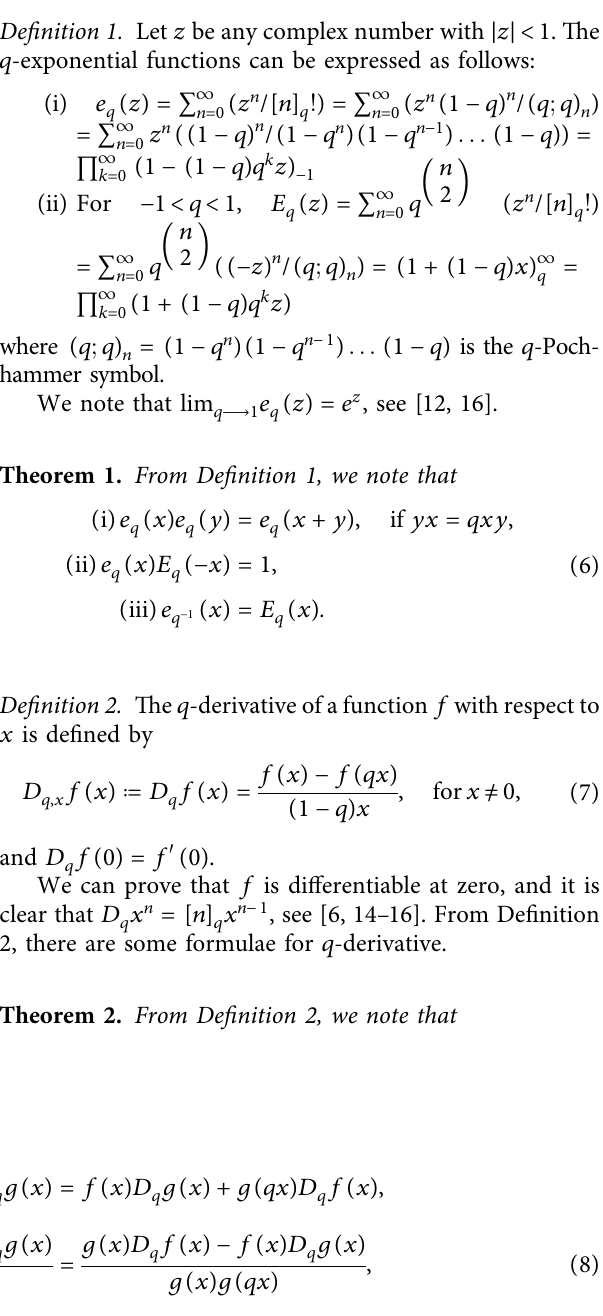
Table 1: Examples of D